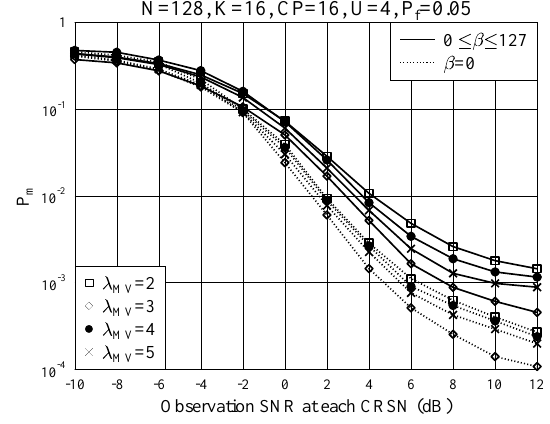
Figure 9. Missing probability of the local CRSNs sensing the spectrum of an IFDMA system with 128 subcarriers to support maximum 16 users, when the MVD associated with various values for λ is MV